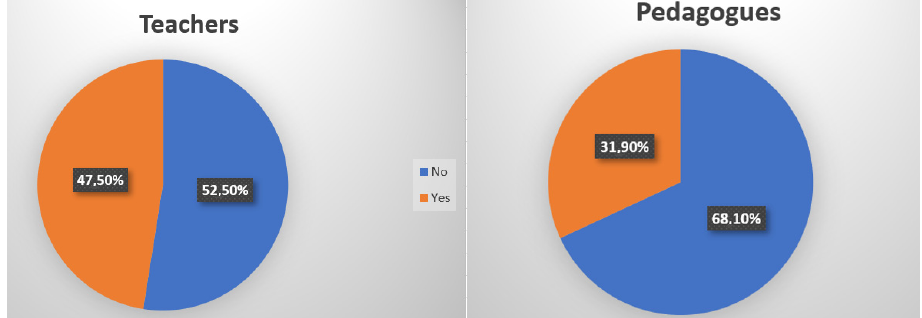
Figure 2. Teachers’ and pedagogues’ difficulties—correcting tasks online.